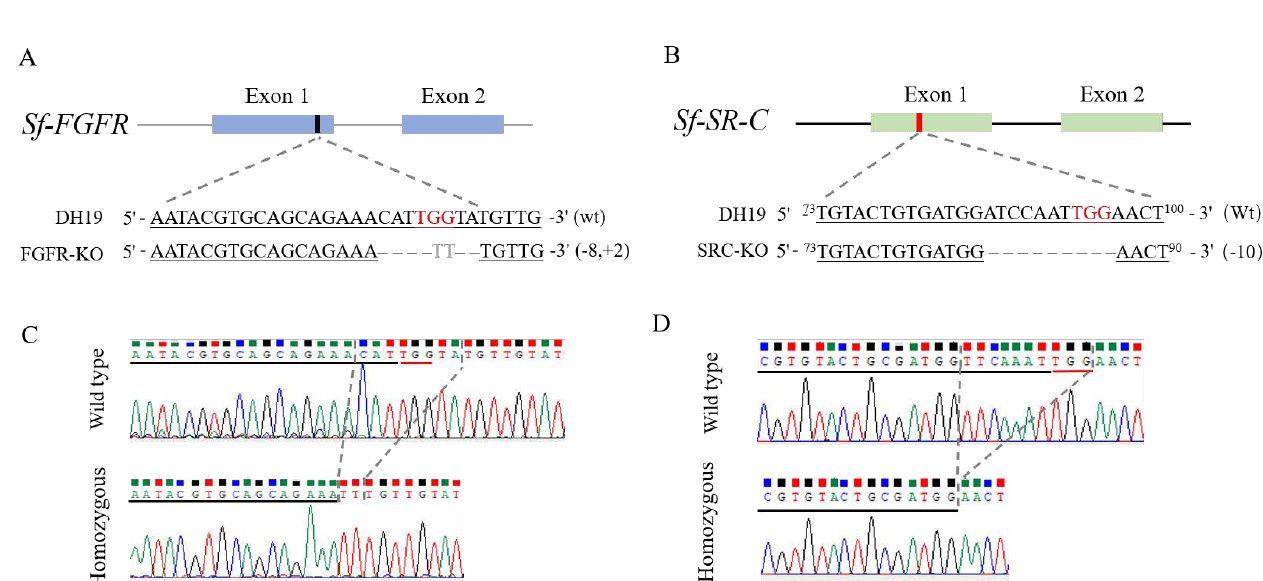
Figure 1. Sequence-specific mutation types of the Sf-FGFR and Sf-SR-C genes of S. frugiperda mediated by the CRISPR/Cas9 gene-editing system. ( A , B ) Schematic diagrams of sgRNA targeting sites and Sequence-specific mutation types of Sf-FGFR and Sf-SR-C genes. ( C , D ) Chromatograms of DNA sequences of selected homozygotes of Sf-FGFR and Sf-SR-C .